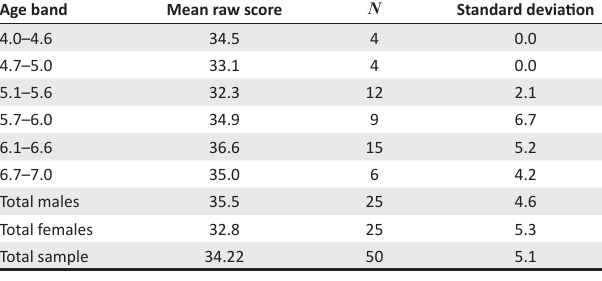
TABLE 2: Performance on Ingwavuma receptive vocabulary test by age.